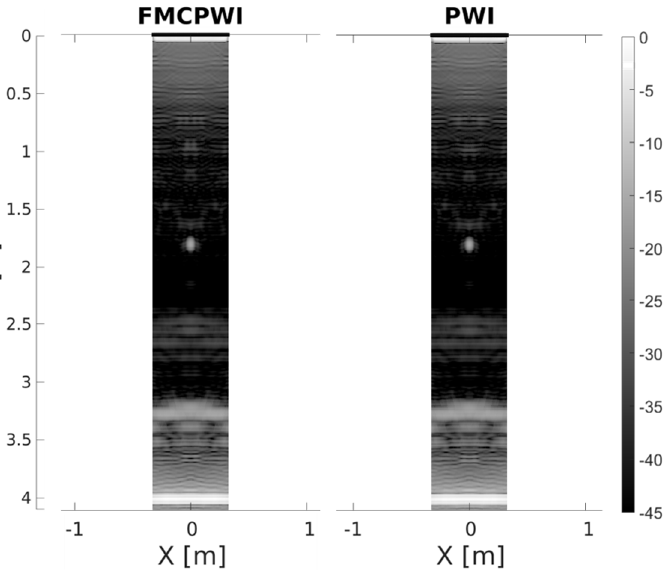
Figure 10. Comparison of FE FMCPWI ( left ) and FE PWI ( right ) reconstructions presented in the form of unwrapped pipe. X and z are circumferential and axial directions, respectively.